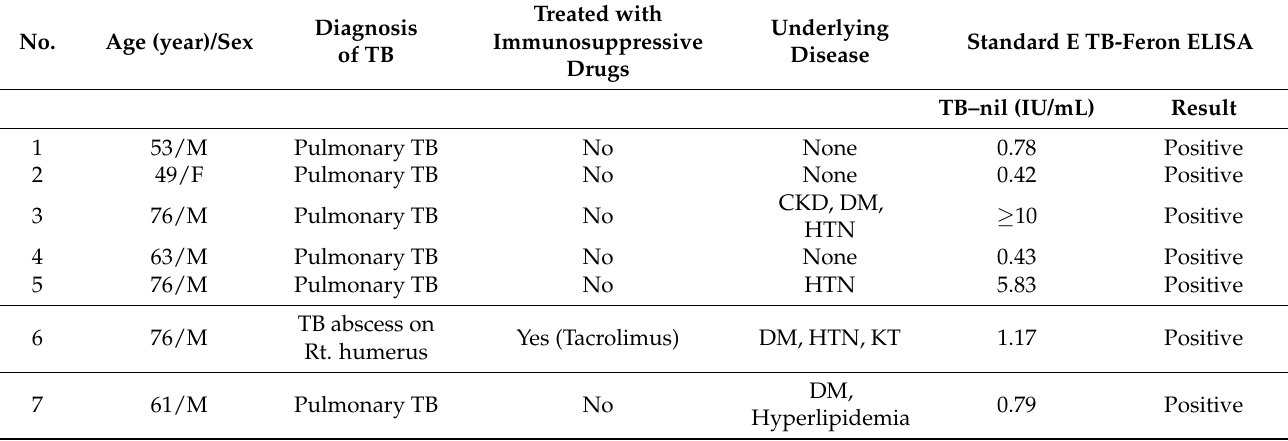
Table 4. Characteristics of seven TB patients with discordant results (Standard E TB-Feron ELISA (positive) and QuantiFERON-TB Gold Plus assay